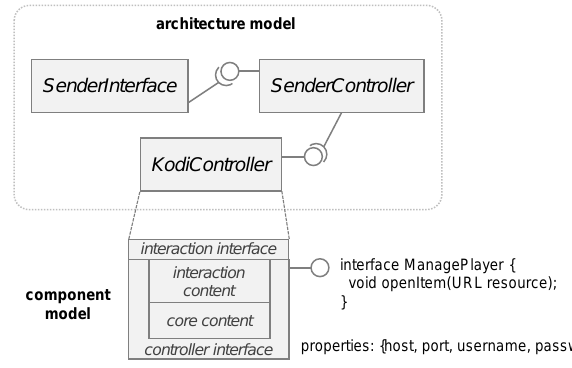
Figure 3. Component model required by the COScore